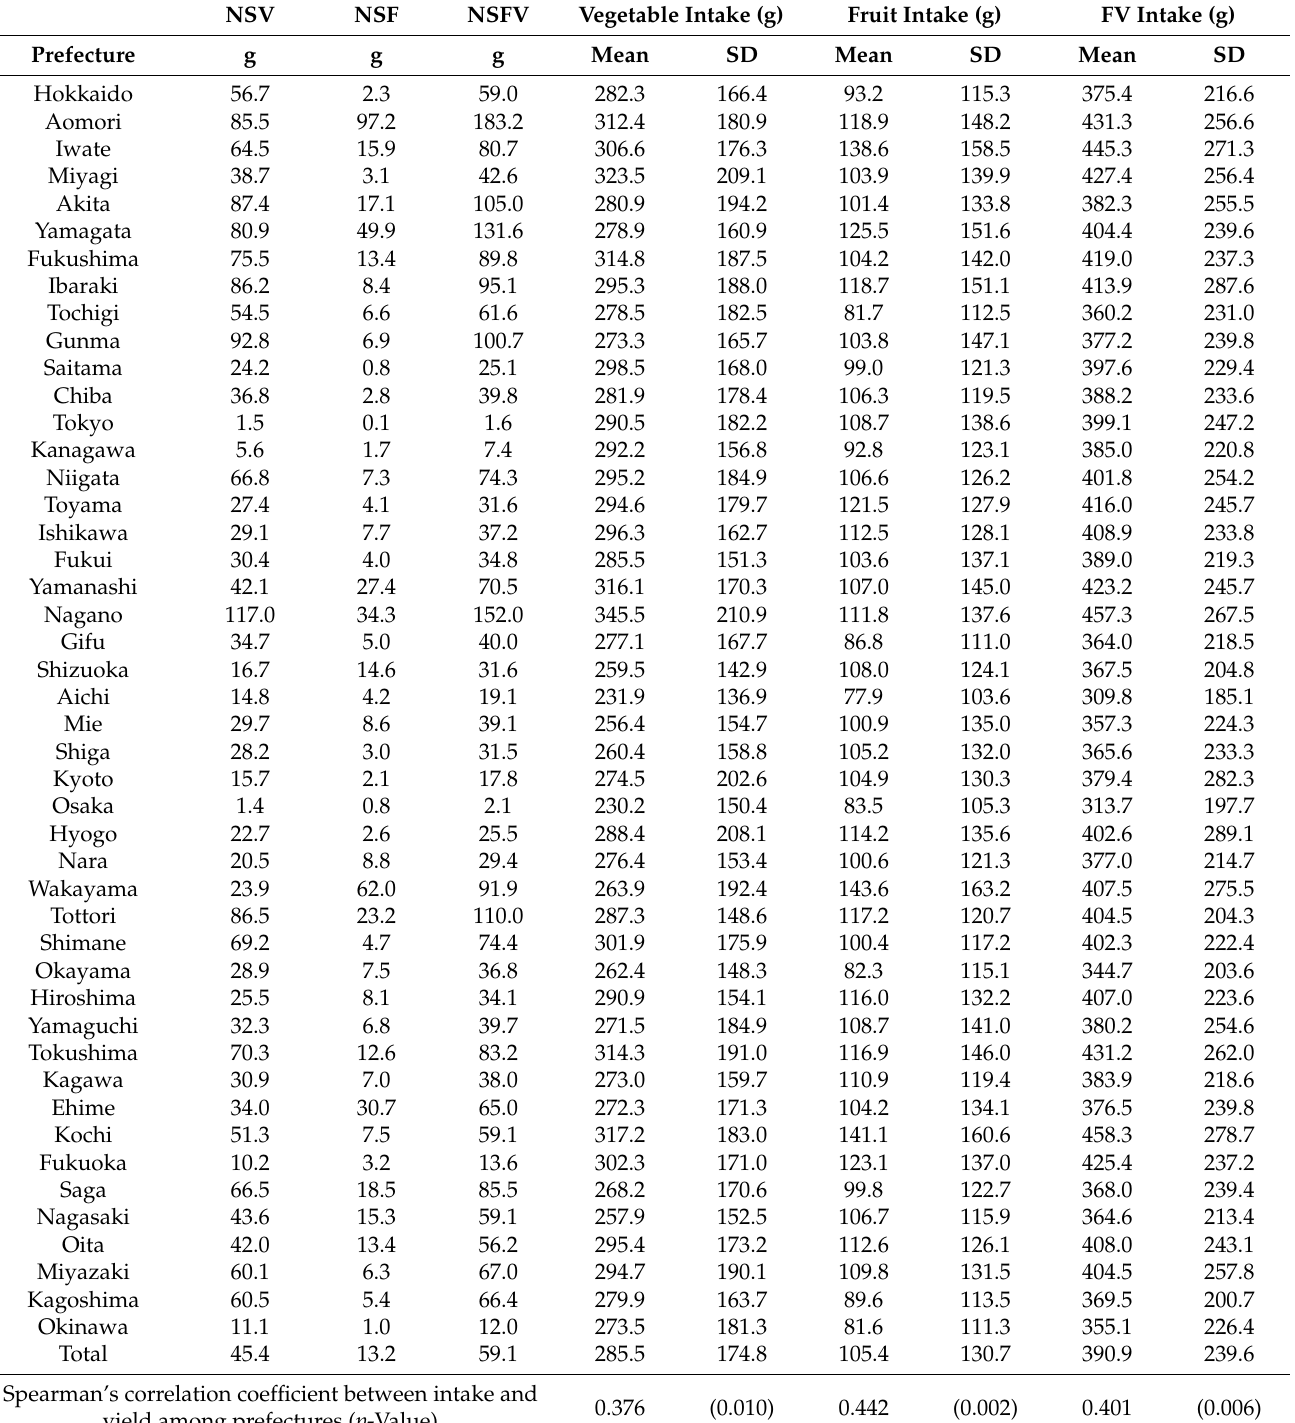
Table 3. Yield of not-for-sale fruits and vegetables and fruit and vegetable intake according to